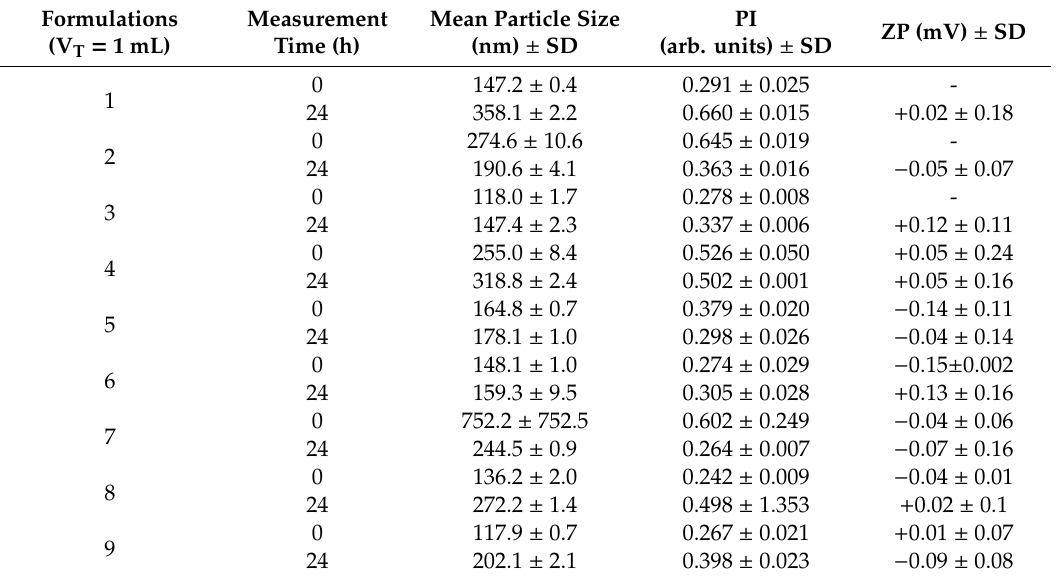
Table 6. Mean particle size, polydispersity index (PI) and zeta potential (ZP) of formulations without solid lipid (no. 1–6) and formulations with solid lipid (no. 7–12), measured immediately